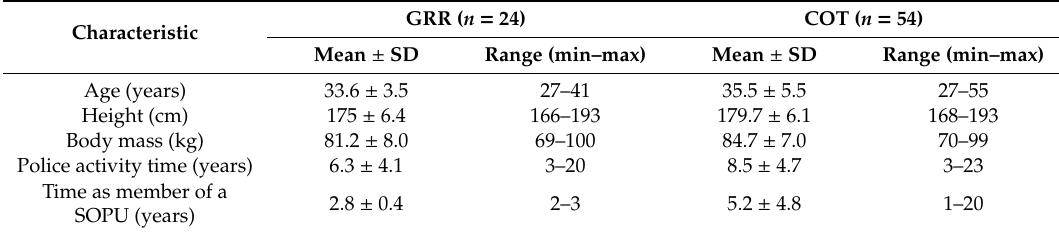
Table 1. Demographic characteristics of the two study cohorts of police o ffi cers, Brasilia (Brazil), 2019. GRR ( n = 24) COT ( n = Characteristic